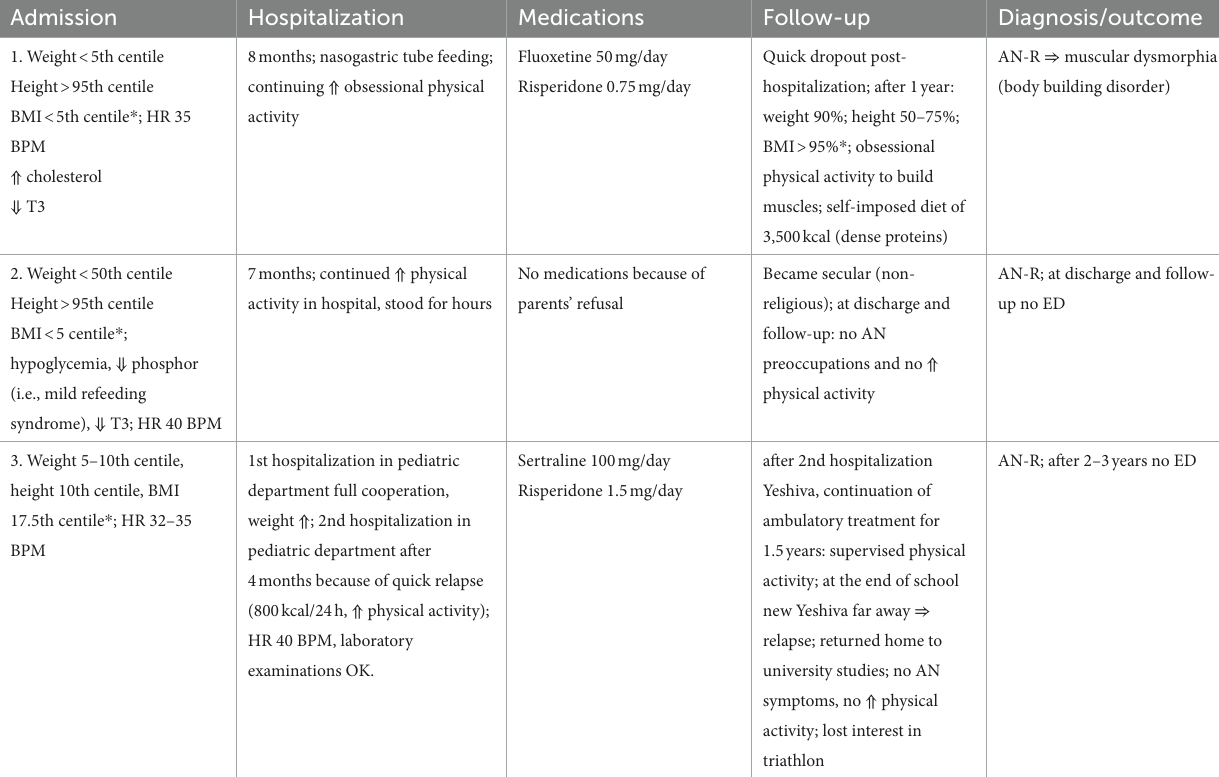
TABLE 2 Three adolescents with DSM 5-TR AN: admission, hospitalization and post-hospitalization data. Admission